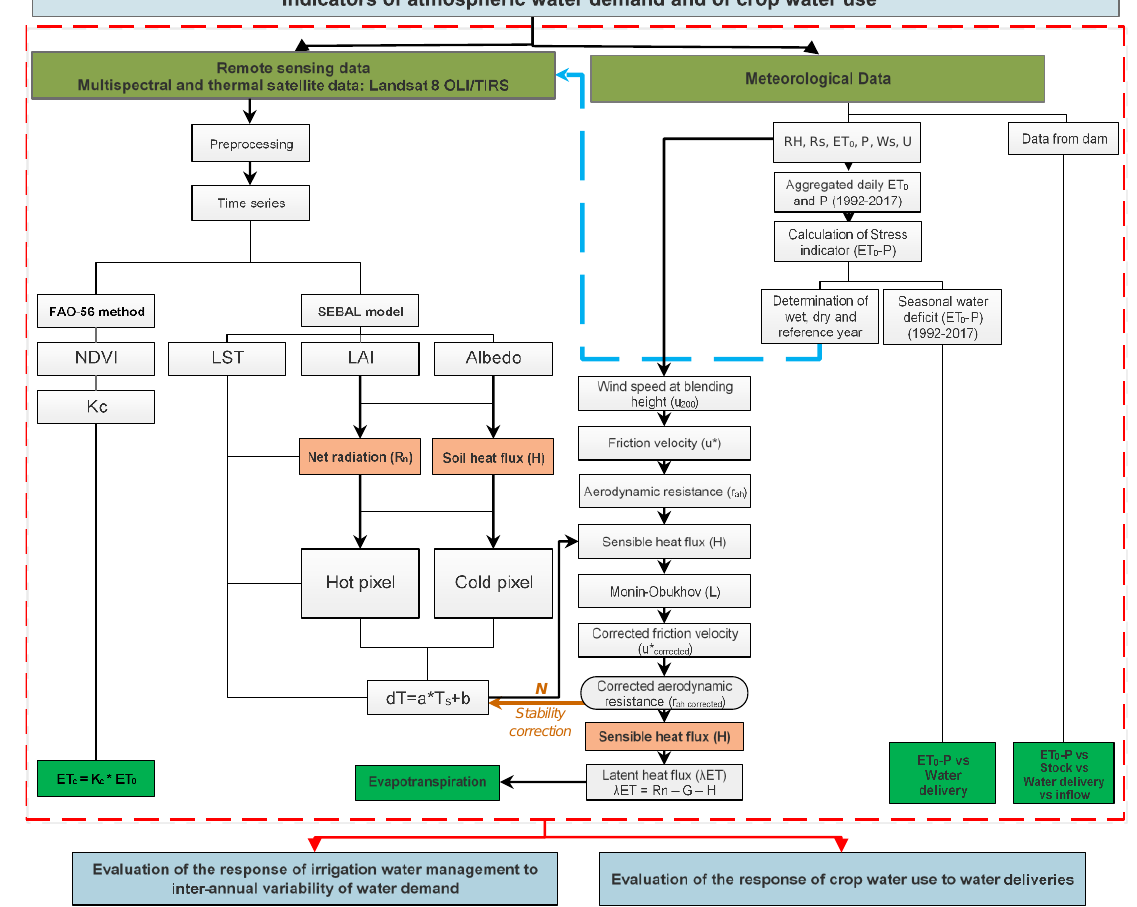
Figure 2. Workflow of the methodology applied.